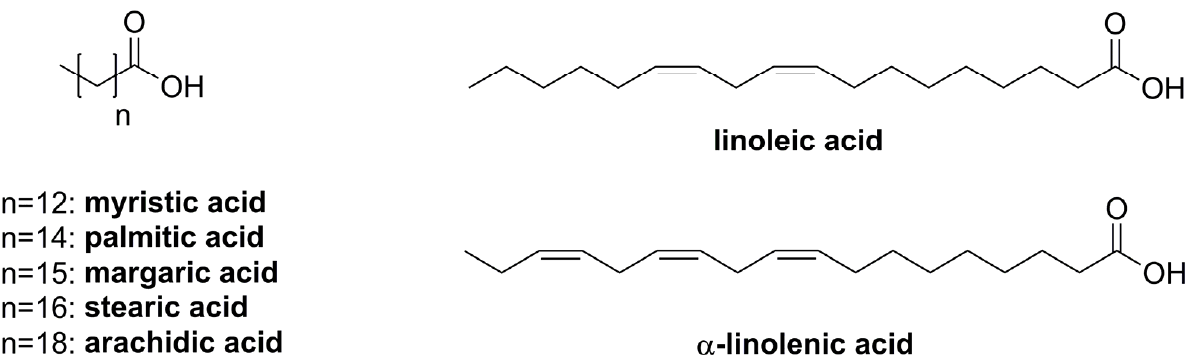
Figure 2. Chemical structures of analyzed fatty acids.